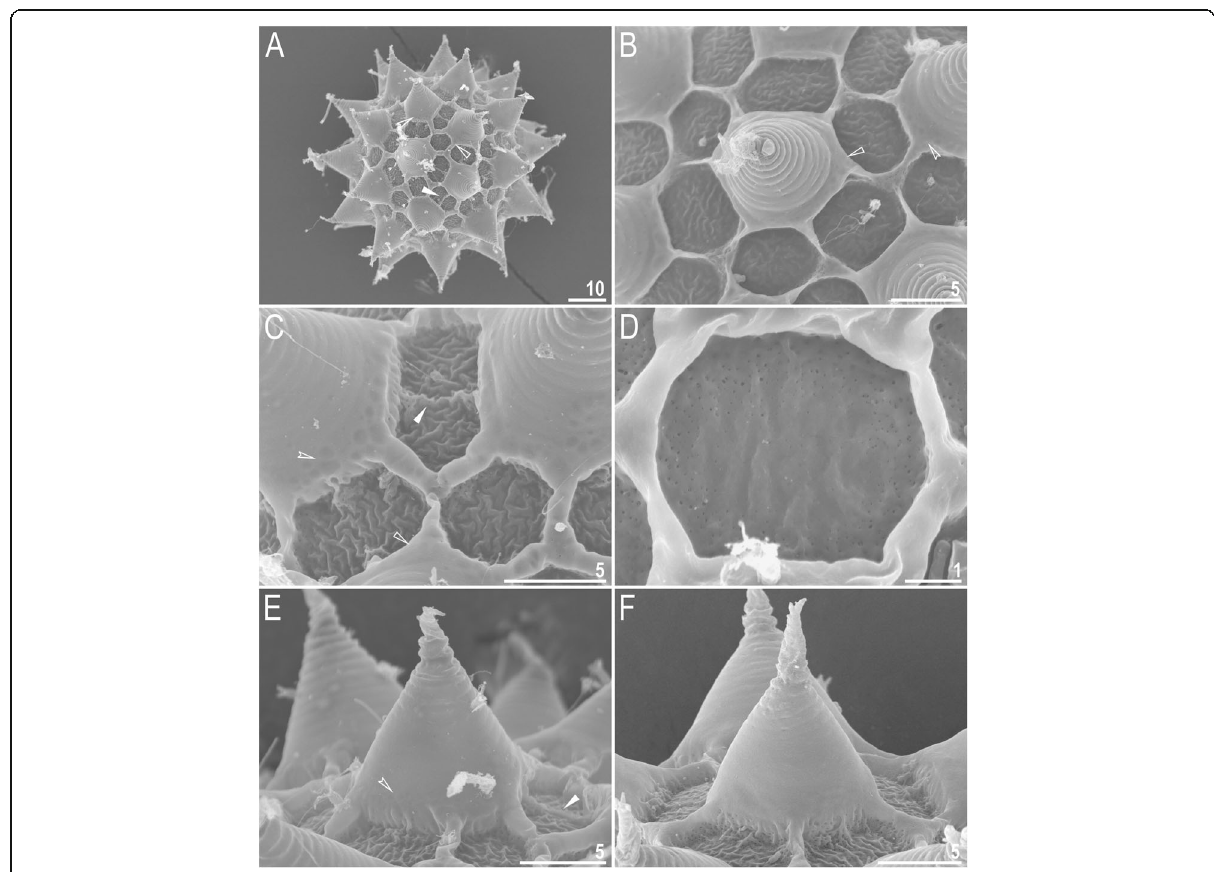
Fig. 28 Macrobiotus ripperi sp. nov. from Poland (PL.015) – eggs seen with SEM: a – entire view of the egg; b – f – details of the egg surface between processes, areolation and egg processes. Filled flat arrowheads indicate thickening perpendicular to the process base, which divides the areola in the middle, empty flat arrowheads indicate irregular collar around process bases, and empty indented arrowheads indicate rings of the reticulation/labyrinthine layer in the bottom part of egg processes. Scale bars in μ